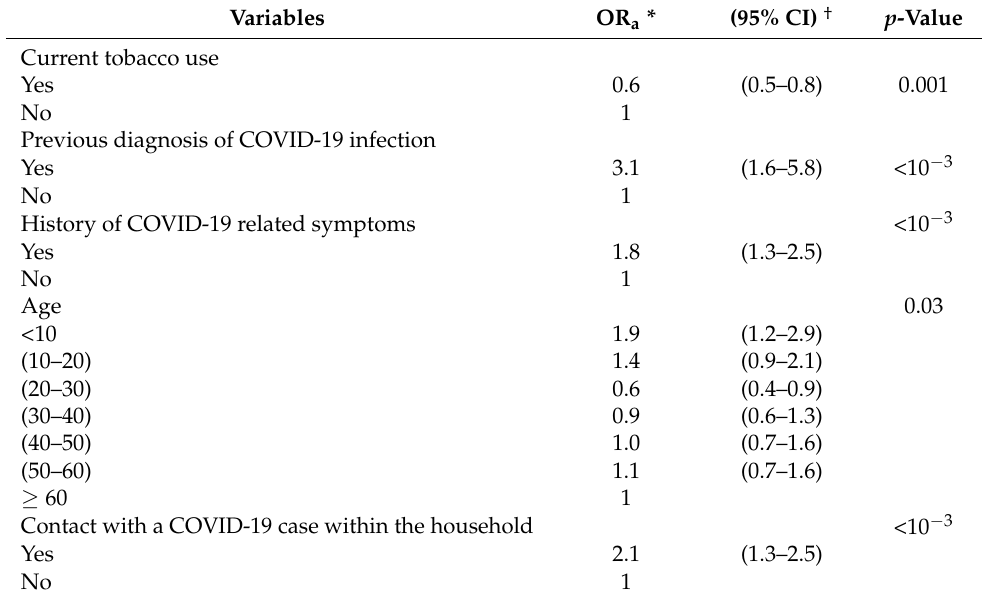
Table 4. Predictors of seropositivity among Tunisian participants as a result of multiple logistic regression